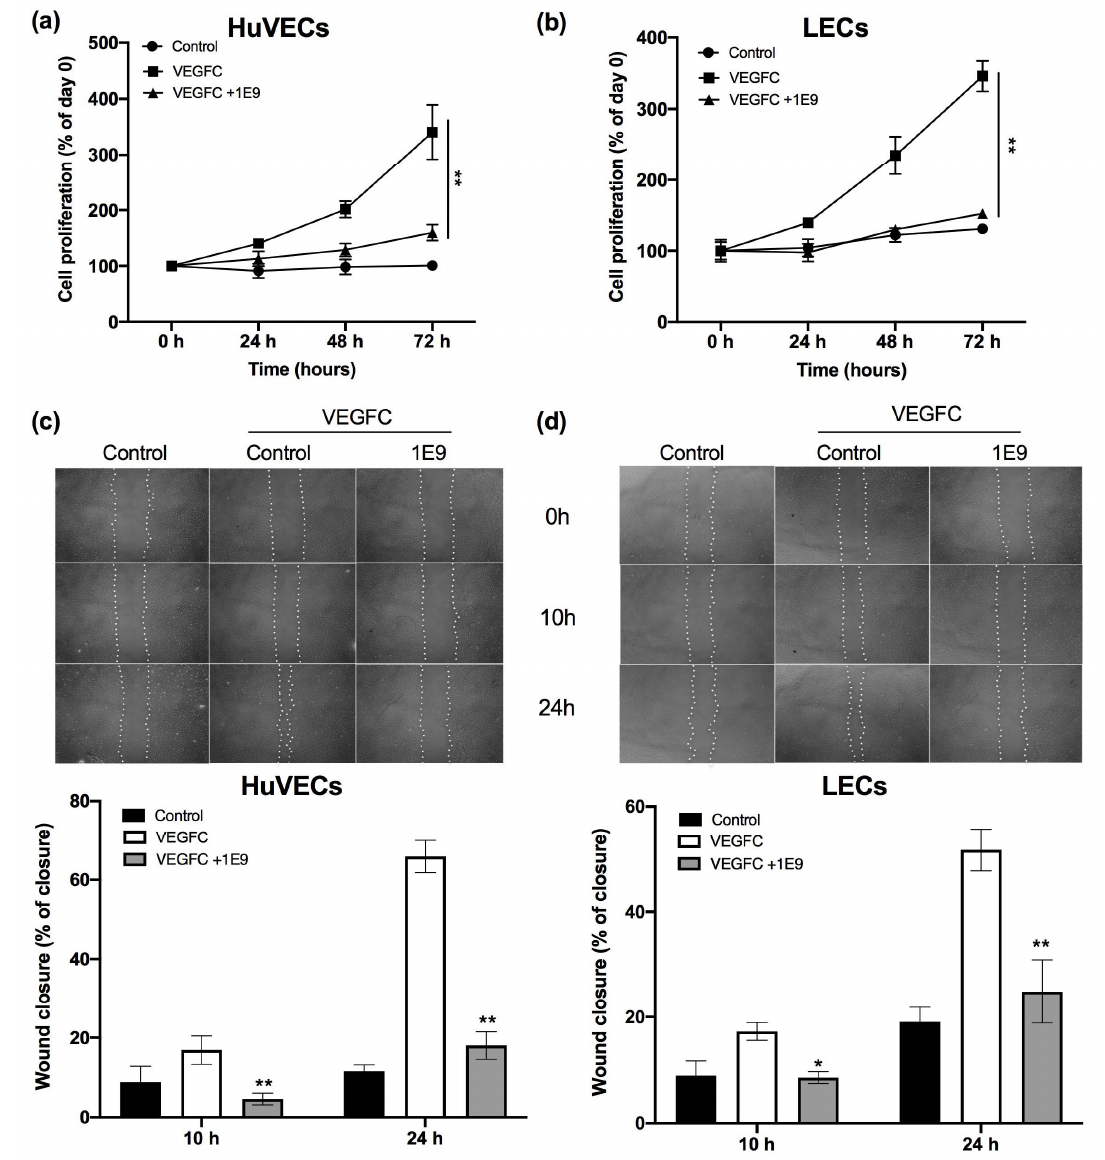
Figure 2. The 1E9 antibodies inhibit the VEGFC-dependent proliferation and migration of endothelial cells. ( a , b ) HuVECs ( a ) and LECs ( b ) were incubated for the indicated times in a medium specific for endothelial cells (control), or with 100 ng/mL of the non-maturated form of VEGFC in the presence of 10 µg/mL of 1E9 antibodies or not. ** p < 0.01 vs. VEGFC. ( c , d ) HuVECs ( c ) and LECs ( d ) were incubated in medium specific for endothelial cells (control), or in the presence of 100 ng/mL of the non-maturated form of VEGFC (VEGFC) with 10 µg/mL of irrelevant antibodies, or in the presence of 100 ng/mL of VEGFC with 10 µg/mL of 1E9 antibodies. Wound closure was estimated after incubation for 10 h and 24 h. Statistics are indicated; * p < 0.05, ** p < 0.01 vs. VEGFC.